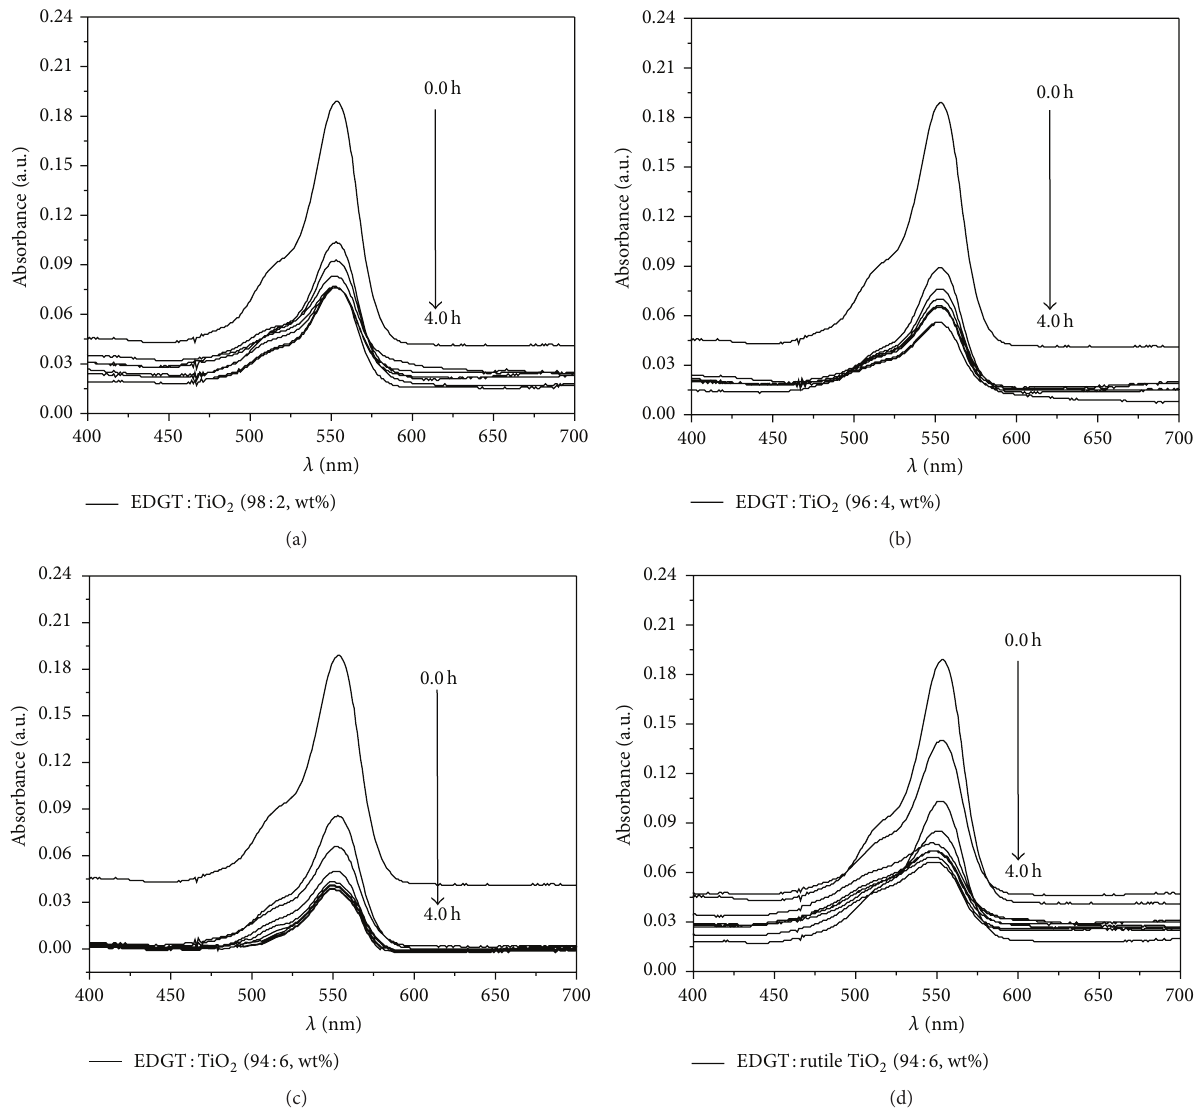
Figure 7: Absorbance spectrum of residues of rhodamine B under continuous incidence of light (successive curves were acquired at fixed interval of time of 30 min), using 2 wt% (a), 4 wt% (b), and 6wt% (c) of anatase and 6wt% of rutile (d) in fibers as a